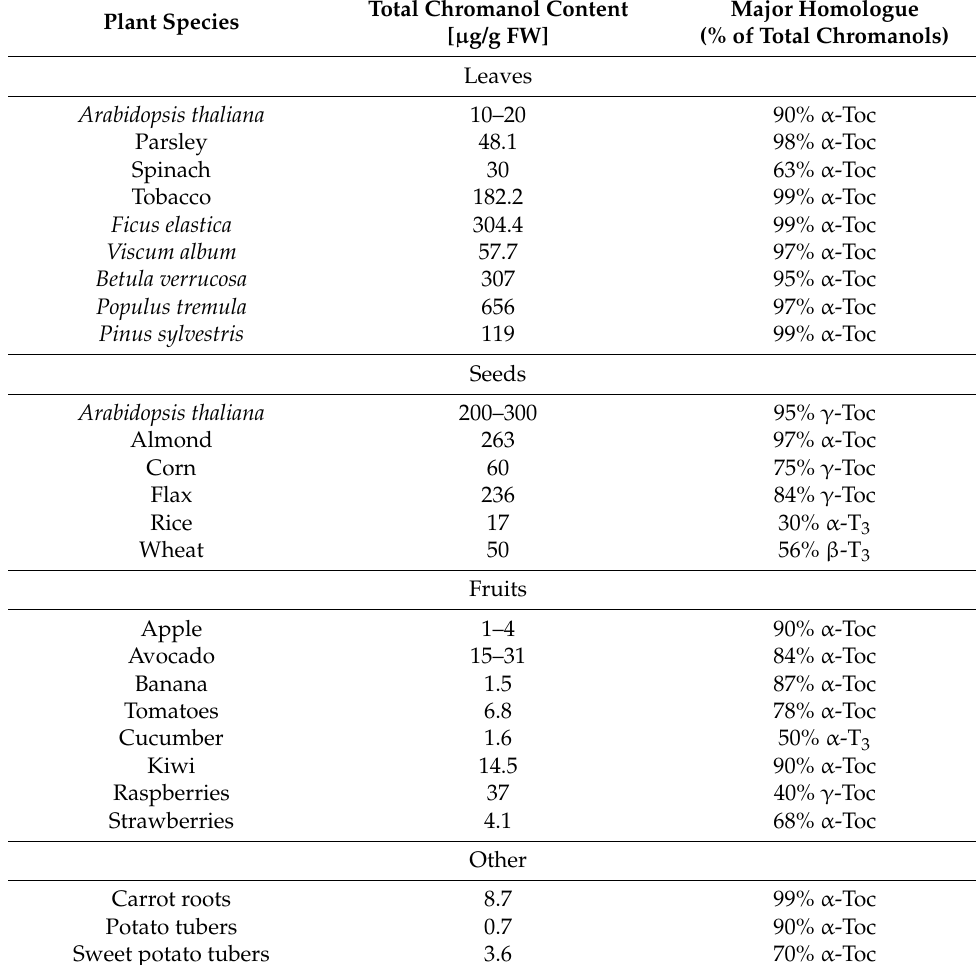
Table 1. The content of isoprenoid tocochromanols in plant organs. Toc, tocopherol; T 3 , tocotrienol